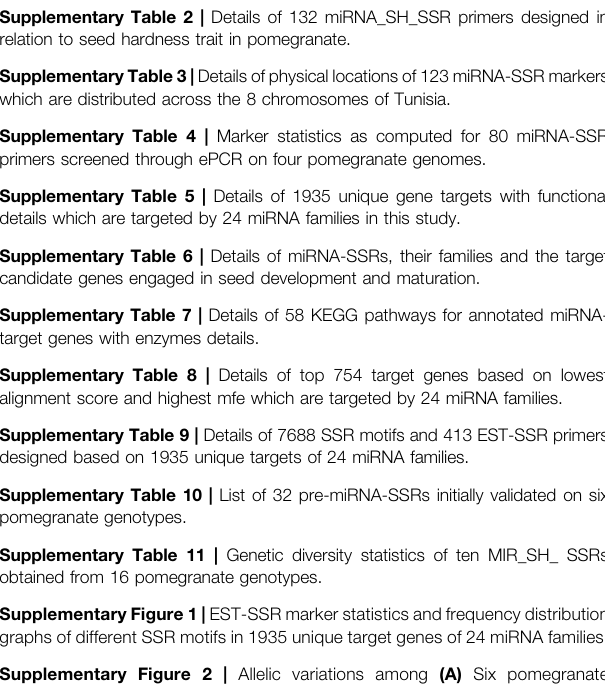
Supplementary Figure 2 | Allelic variations among (A) Six pomegranate genotypes using MIR_SH_SSR markers 64, 65, 67, 69, 71, 81, 84 and 86, and (b) Sixteen pomegranate genotypes using MIR_SH_SSRs 26, 29 and 37. (Where, L-100 bp DNA ladder, Lane 1 – 6 and Lane 1 – 16 set of